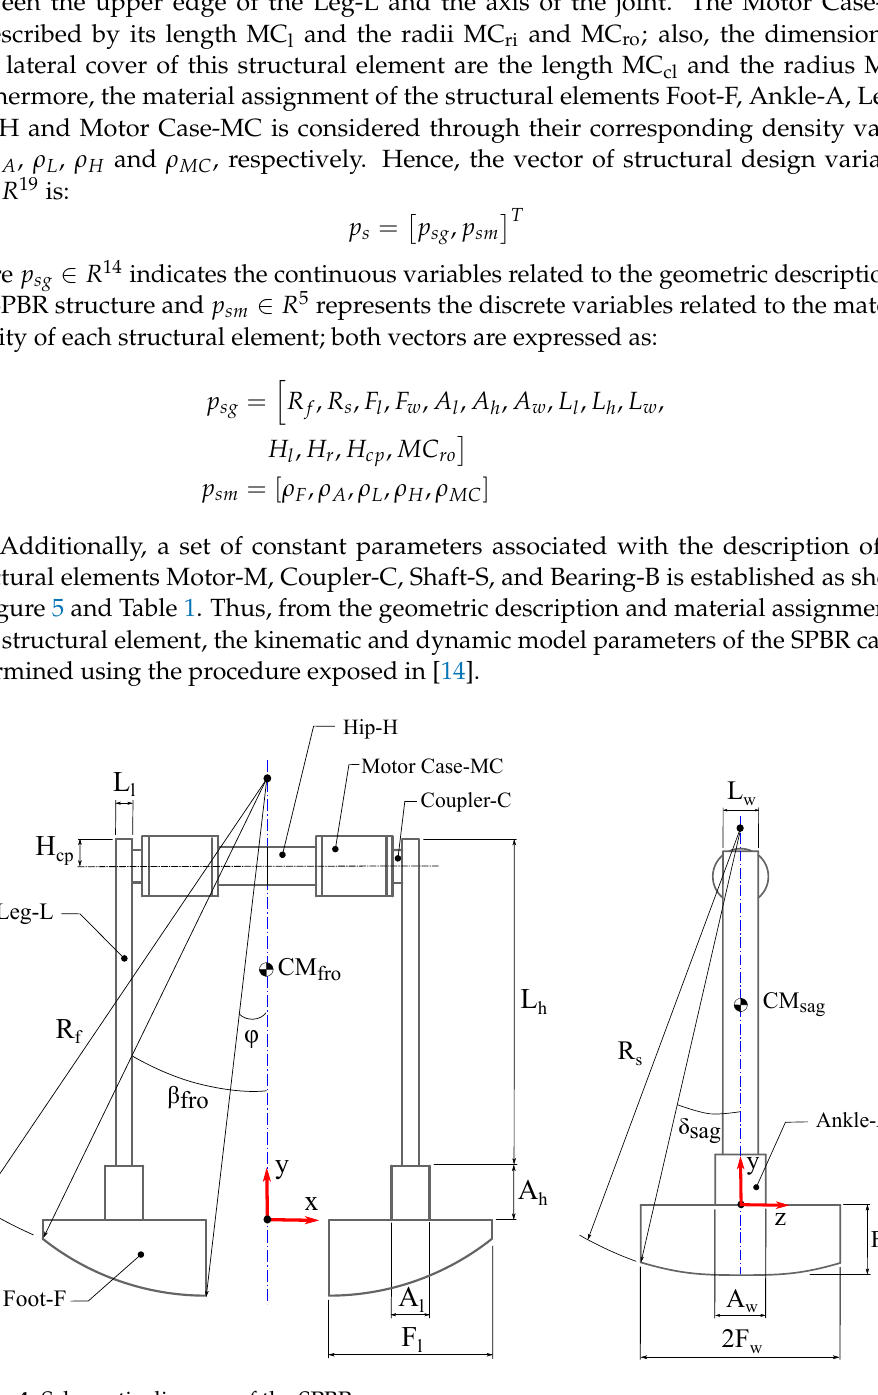
Figure 4. Schematic diagram of the